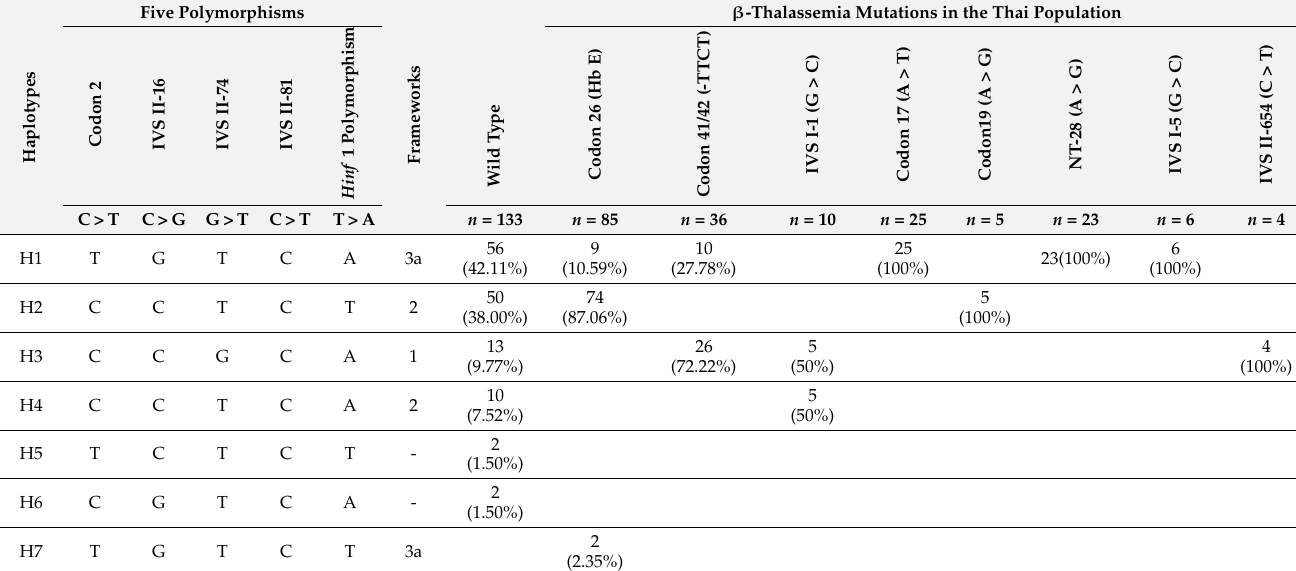
Table 3. Haplotype constructed using four intragenic polymorphisms on the β -globin gene and Hinf I polymorphism on the 3 (cid:48) β -globin gene of β -thalassemia mutations and wild type in Thai population. Values indicates number of samples and